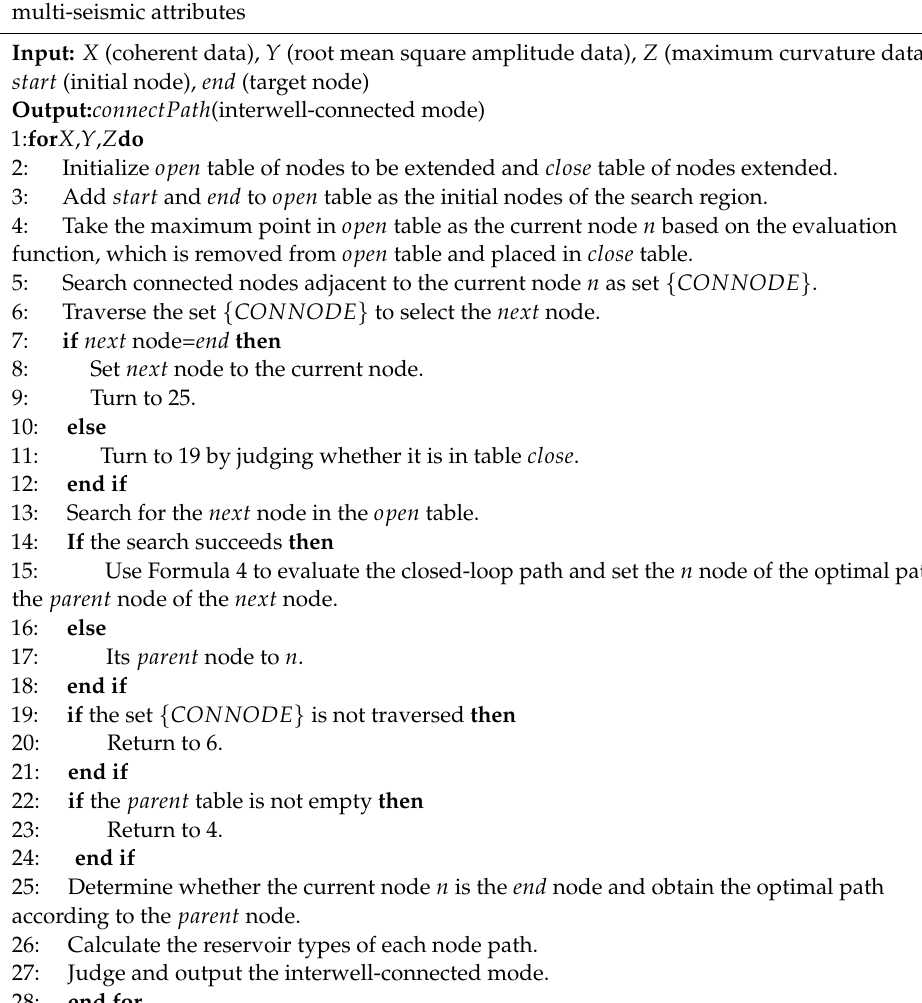
Algorithm 1: The evaluation algorithm of static-connected modes based on the fusion of multi-seismic